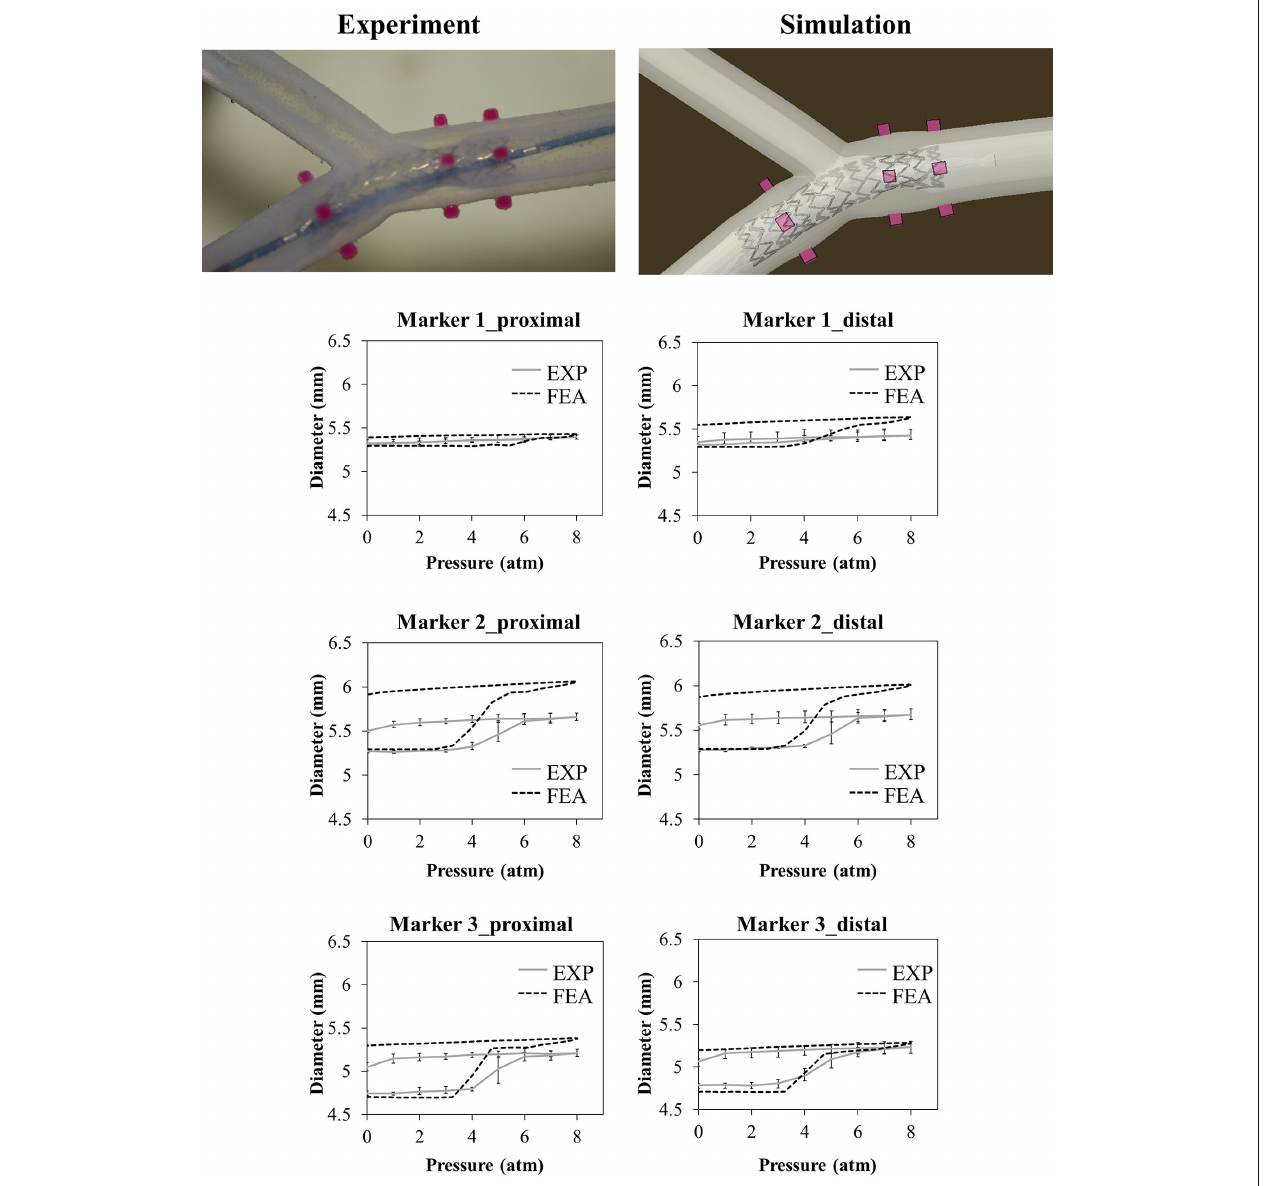
FIGURE 8 | Comparison between experimental and numerical results of the deployments of the SYNERGY TM stent in a bifurcated vessel, taken at Marker 1,2,3 (from proximal to distal). A qualitative comparison between experimental and numerical configuration is reported considering the final instant of the balloon deflation